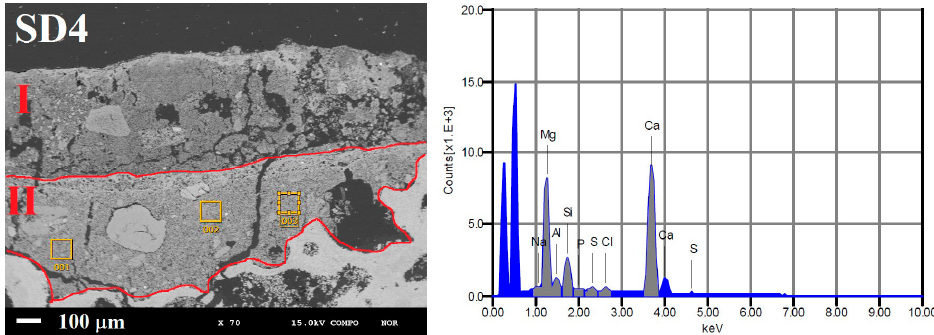
Figure 6. EMPA-EDS image of sample SD4 showing morphological features of multi-layered superficial patina (I and II layer) and some analysed areas (squared areas in II layer) by EDS.